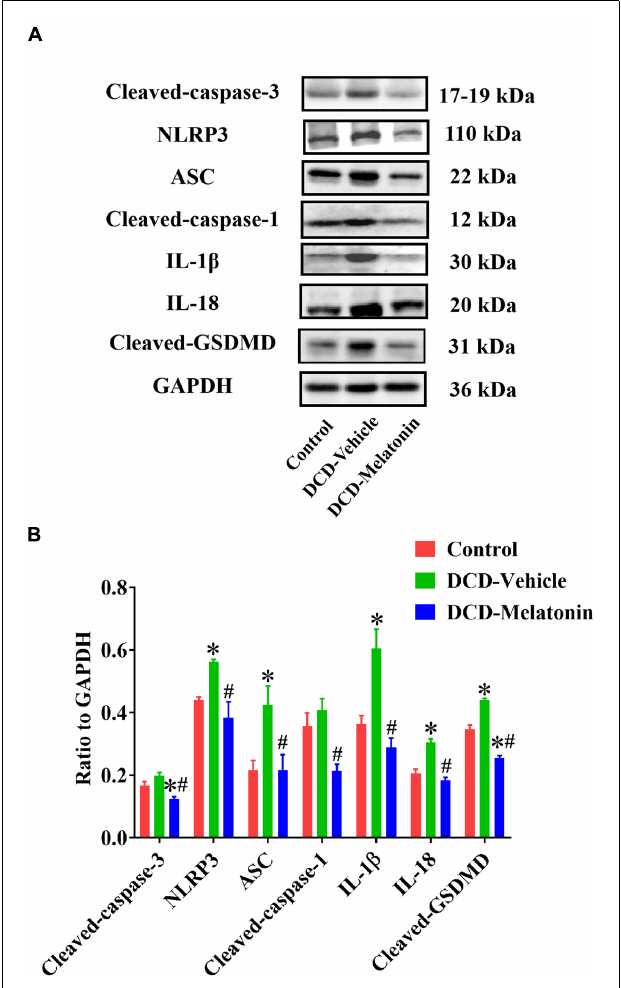
FIGURE 7 | Representative Western blotting and quantitative analysis of the effect of melatonin treatment on apoptosis and NLRP3 inflammasome-mediated pyroptosis in the hearts preserved with EVHP. (A) Representative protein band densities of cleaved caspase-3, NLRP3, ASC, cleaved caspase-1, IL-1 β , IL-18, and cleaved GSDMD; and (B) quantitative analysis of protein expression in the DCD hearts. Data represent mean ± standard error of the mean. n = 4 for each group. DCD, donation after circulatory death; EVHP, ex vivo heart perfusion. ∗ p < 0.05 vs. Control; # p < 0.05 vs.